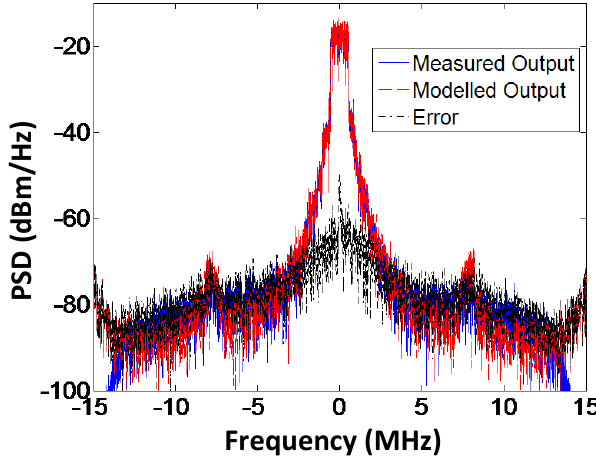
Figure 15. Spectral response of the modeled and measured output along with the error signal for the branch-by-branch digital combining architecture. The modeled output spectrum is closer to the measured spectrum leading to reduced error.